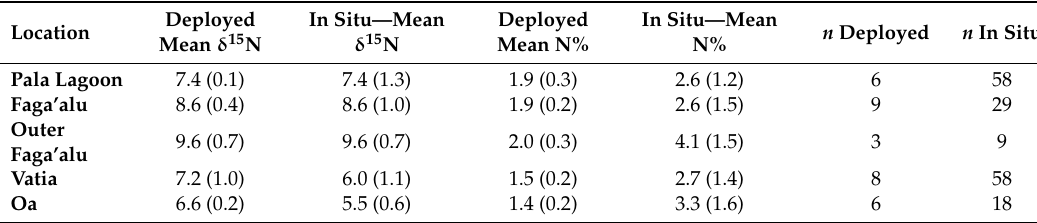
Table 3. Mean values and standard deviation in N-parameter values for both deployed and in situ algal samples. 1 σ standard deviations are provided in